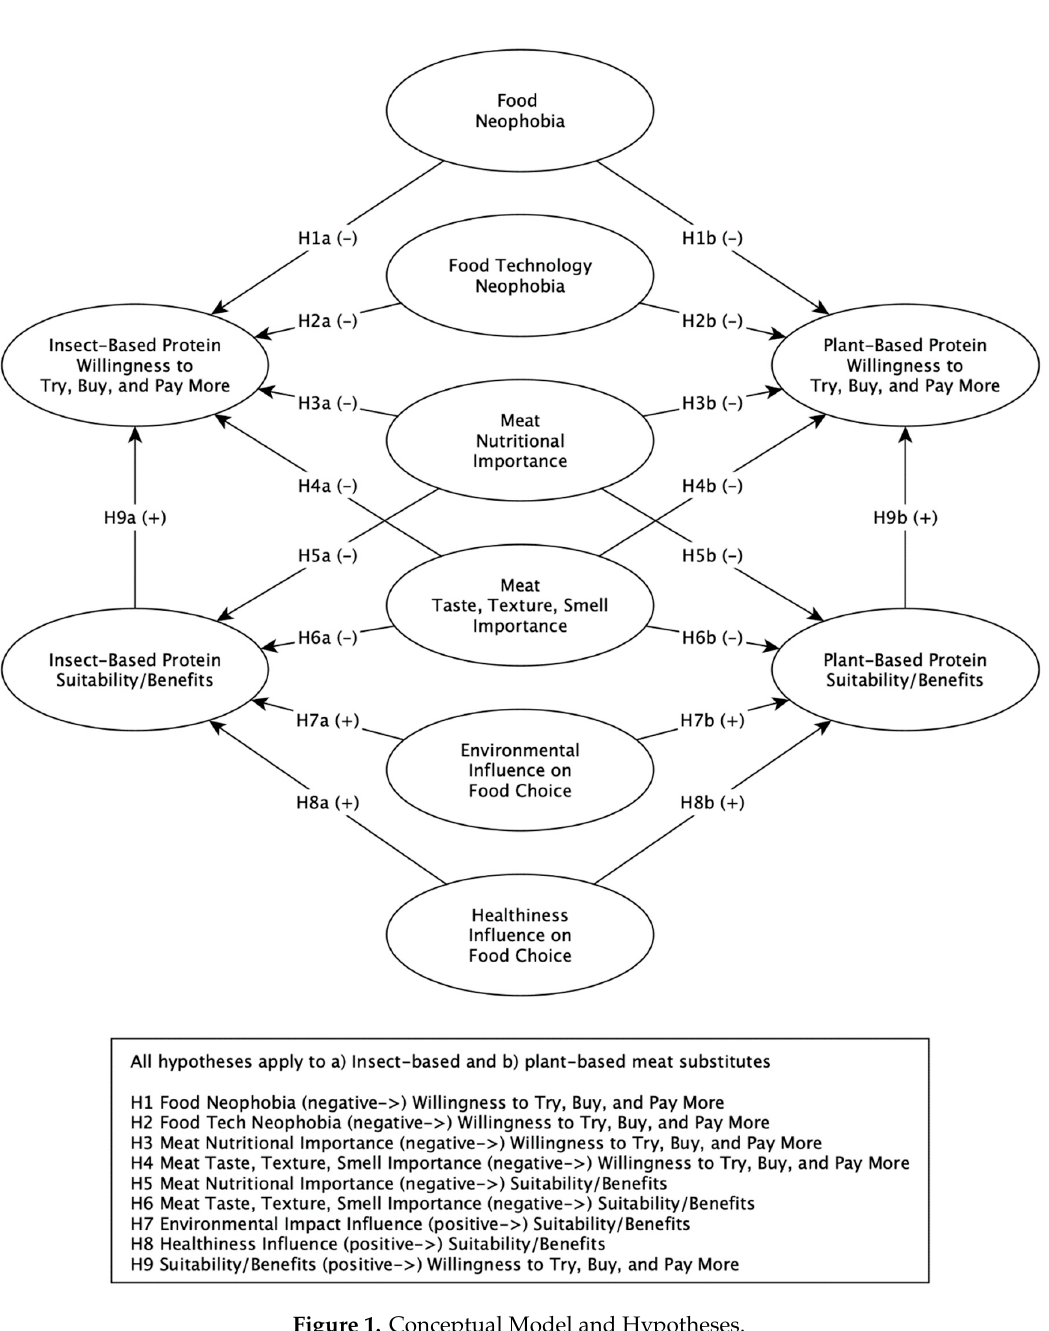
Figure 1. Conceptual Model and Hypotheses.